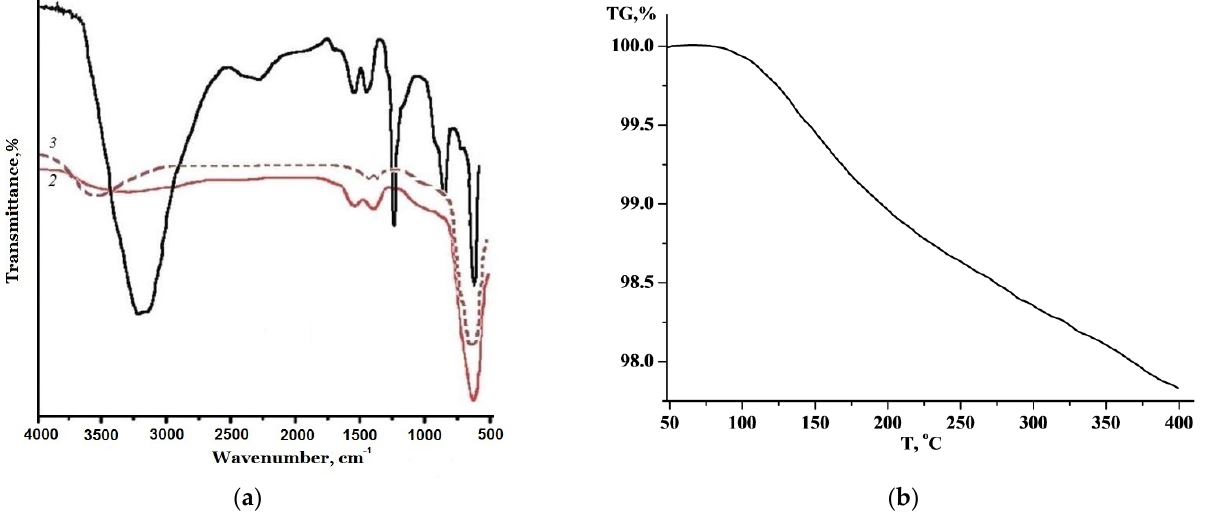
Figure 5. ( a ) FTIR spectra of ZnSn(OH) 6 ( 1 ) and ZnSnO 3 obtained by the thermolysis of ZnSn(OH) 6 ( 2 ) and kept in air for some time ( 3 ). ( b ) Dependence of mass change (TG) of a ZnSnO 3 sample after storage in an air atmosphere of a desiccator.